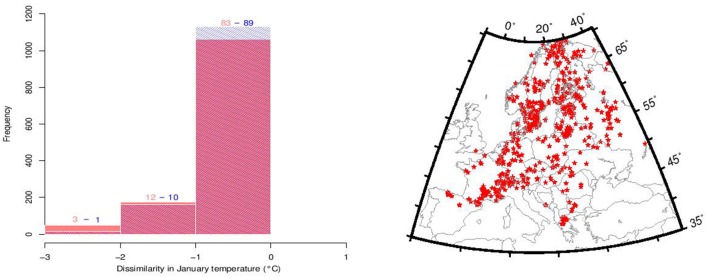
Evaluation of the impact of Abies alba, Fagus sylvatica, and Picea abies and their Holocene thermal niche shift on the reconstructed Tjan values using dissimilarity between the modern Tjan (WorldClim, Hijmans et al., 2005) and (1) reconstructed Tjan from a data-set of 1132 modern pollen samples from which the three species were excluded (red histograms) and (2) the same modern pollen data-set including the three species but using their overall Holocene Tjan range (blue histograms) based on reconstructed Tjan between 10 and 3 ka (see Figure 3). Numbers over the histograms correspond to the percentages of pollen samples that deviate from 0. Between 83 and 89% of the reconstructed Tjan deviate by less than 1°C to the observed Tjan values from WorldClim (Hijmans et al., 2005). The map in the right panel shows the location of the modern pollen samples used for the dissimilarity analysis.